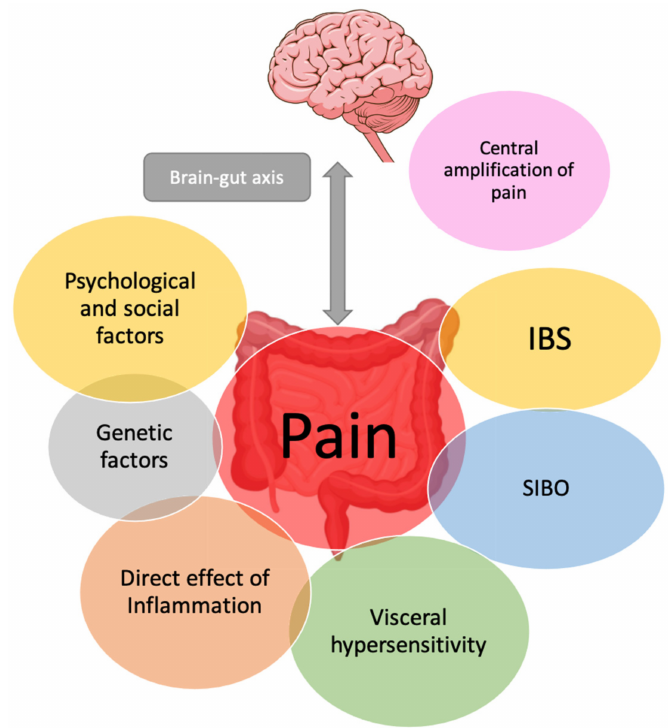
Figure 1. Proposed representation of mechanisms and multiple contributing factors implicated in abdominal pain in IBD: psychological and social factors, genetic factors, direct effect of inflammation, visceral hypersensitivity, co-existent IBS or central pain dysregulation. Abbreviations: IBS: irritable bowel syndrome; SIBO: Small intestinal bacterial